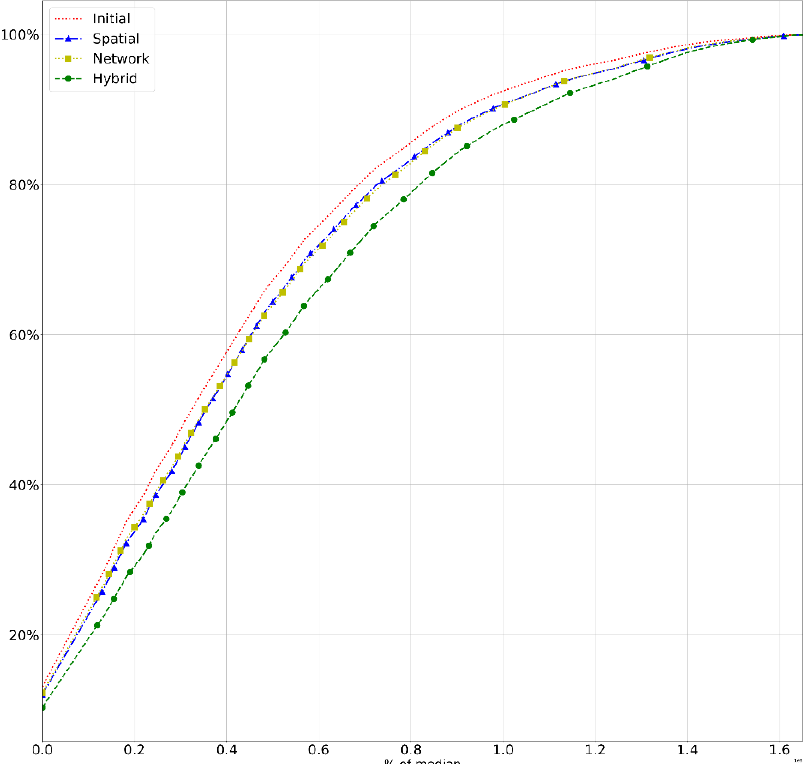
Figure 9. Performance evaluation of each algorithm vs. the initial scenario for normalized through- put (ratio vs median) CDF.